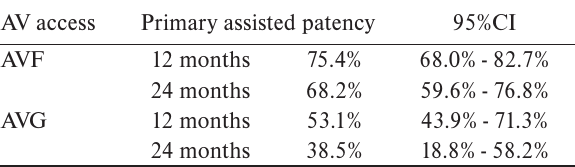
Table 2. Primary assisted patency of all AV accesses.